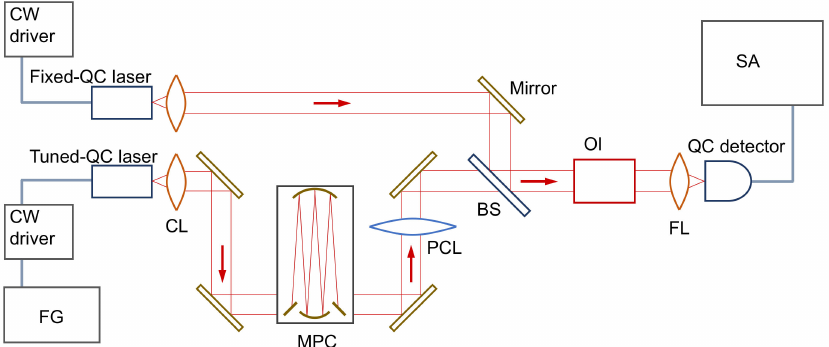
Figure 3. Schematic of heterodyne spectroscopy. FG: function generator, MPC: multi-pass cell, CL: collimating lens (ZnSe, aspheric, working distance of 3 mm), PCL: plano-convex lens (CaF 2 , focal length of 300 mm), FL: focusing lens (ZnSe, aspheric, working distance of 1 mm), BS: beam splitter, OI: optical isolator, and SA: spectrum analyzer.